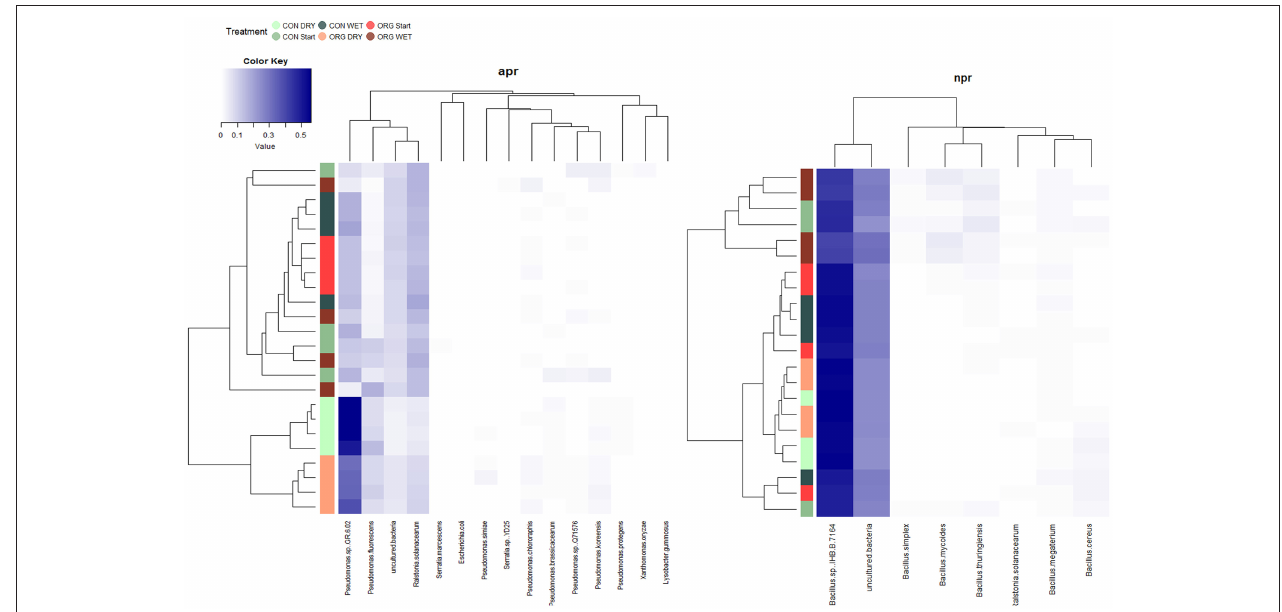
FIGURE 4 | Relative abundance heatmap of alkaline metallopeptidase ( apr ) and neutral metallopeptidase ( npr ) encoding microbial communities (incubation experiment). Only species (or organisms carrying the respective sequence annotated to a species) being more abundant than 0.5% are included in the heatmaps. Samples were clustered based on Bray-Curtis similarities (group-average linkage). Samples (y-axis) are colored according to the treatments conventional (CON), organic (ORG) and the respective water treatments DRY and WET. Color from white to blue indicates higher abundance.